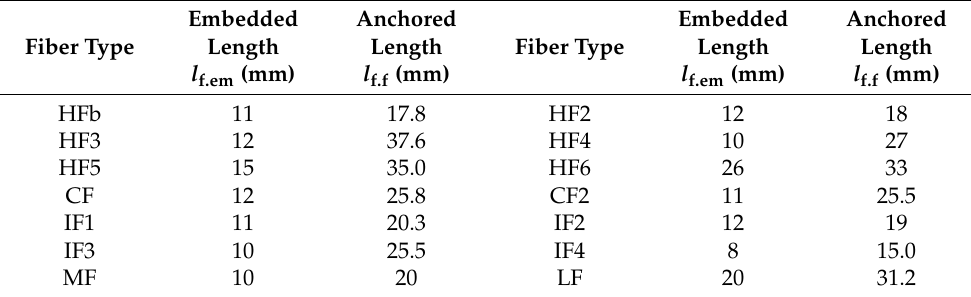
Table 3. The embedded length and anchored length of steel fibers in specimens.